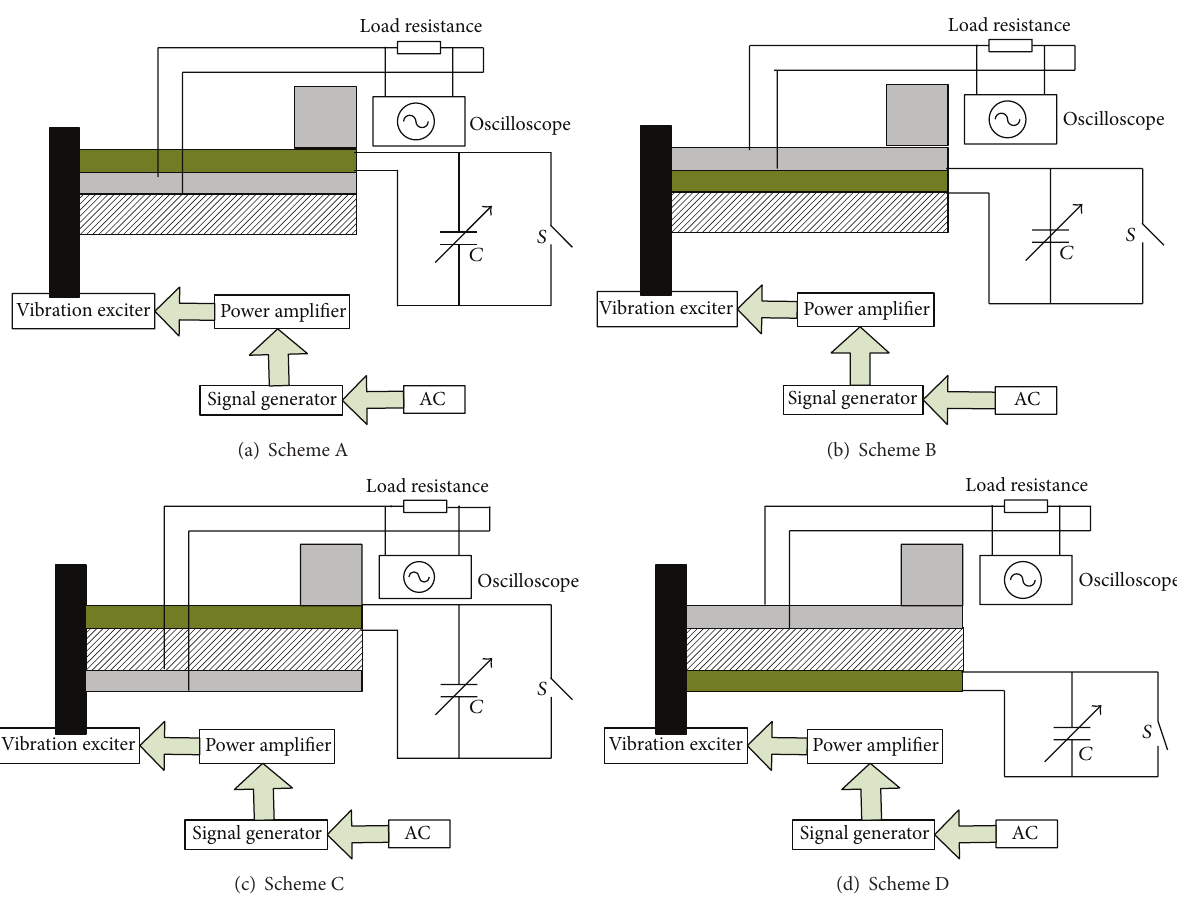
Figure 8: Experiment scheme based on capacitance FM.